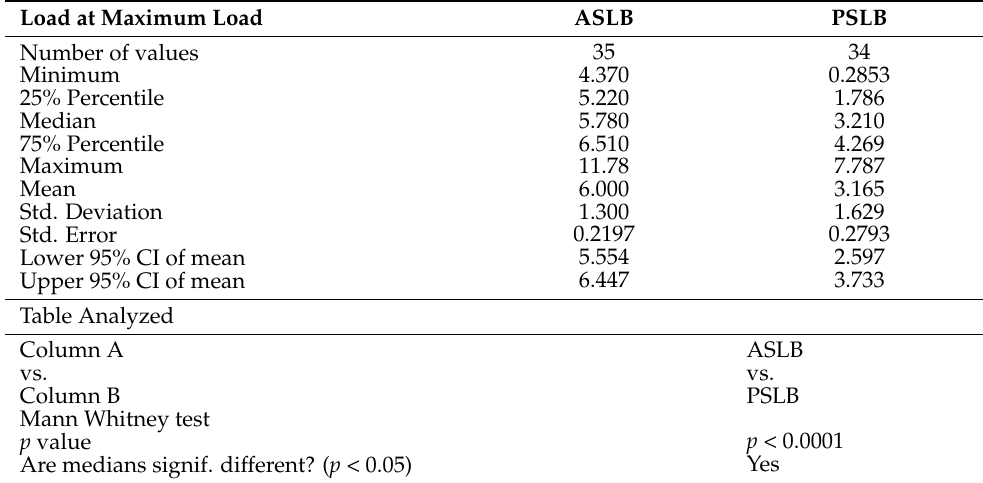
Table A2. Load at maximum load: active vs. passive self-ligating brackets. Load at Maximum Load